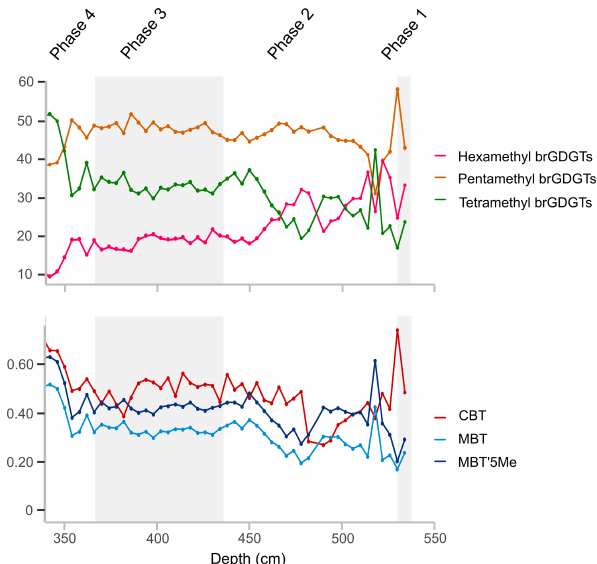
Figure 7. Fractional abundances of tetra-, penta- and hexa- methylated brGDGT degree of methylation (MBT, MBT (cid:48) cyclization ratio (CBT) against depth for the Matese